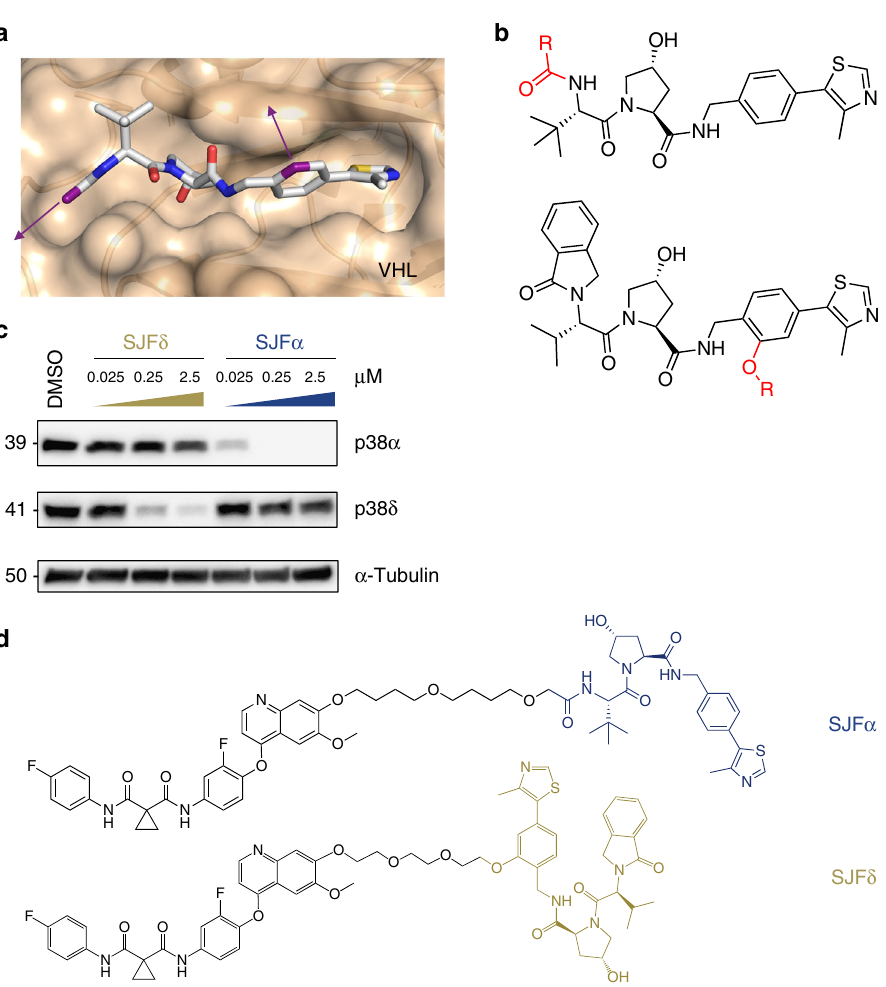
Fig. 1 Foretinib-based PROTACs recruit VHL using two different linkage vectors resulting in isoform-selective degradation. a Crystal structure (PDB: 4W9H) of VHL-recruiting ligand in the HIF-1 α -binding pocket. VHL is rendered as a tan surface with the small molecule ligand visualized in stick representation and colored by atom (gray carbon atoms, red oxygen atoms, blue nitrogen atoms, and yellow sulfur atoms), with the exception of two carbon atoms colored in purple. These purple carbons (and the corresponding purple arrows) represent the structure-guided linker attachment points used in subsequent PROTAC design (see Supplementary Figure 1). b Structures of the two VHL-recruiting ligands used in this study. Top: VHL-recruiting ligand with an amide attachment vector (shown in red). Bottom: VHL-recruiting ligand with a phenyl attachment vector (shown in red). c , d SJF α PROTAC (13- atom linker, amide attachment) selectively degrades p38 α , whereas SJF δ PROTAC (10-atom linker, phenyl attachment) selectively degrades p38 δ in